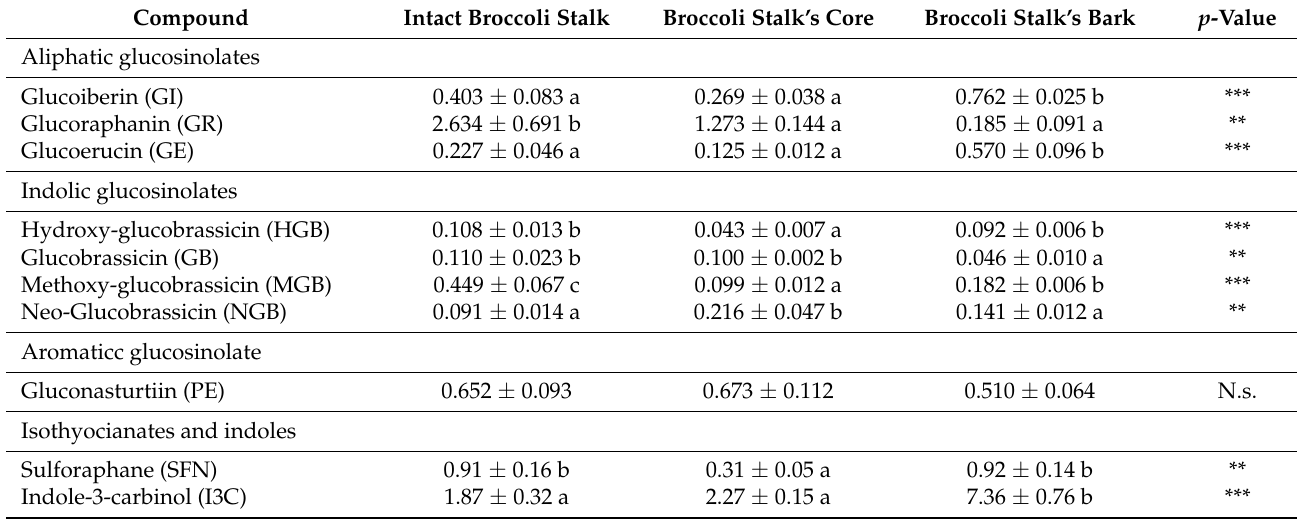
Table 2. Content (g/kg dw) of individual glucosinolates and breakdown products of fresh broccoli stalks fractions (intact stalks, core, and